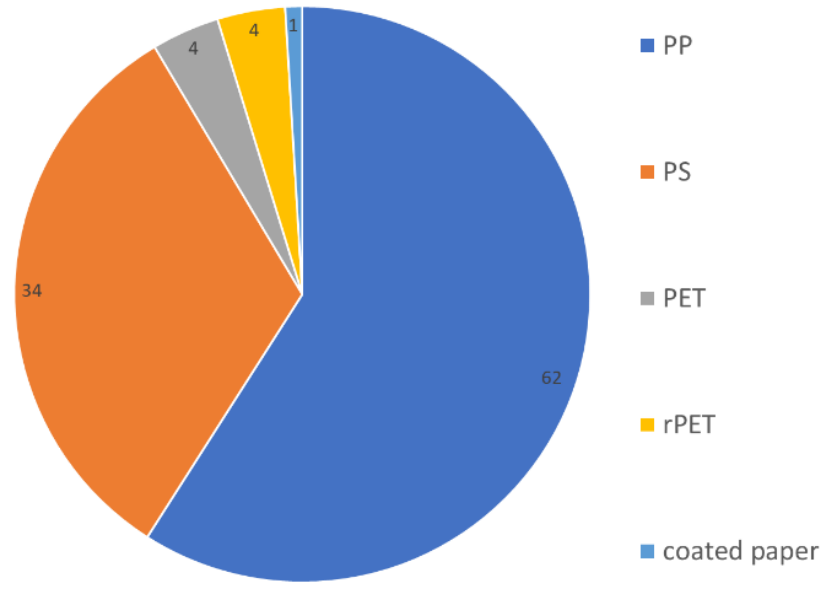
Figure 6. Polymers used for cups; number: number of samples, n = 105 .